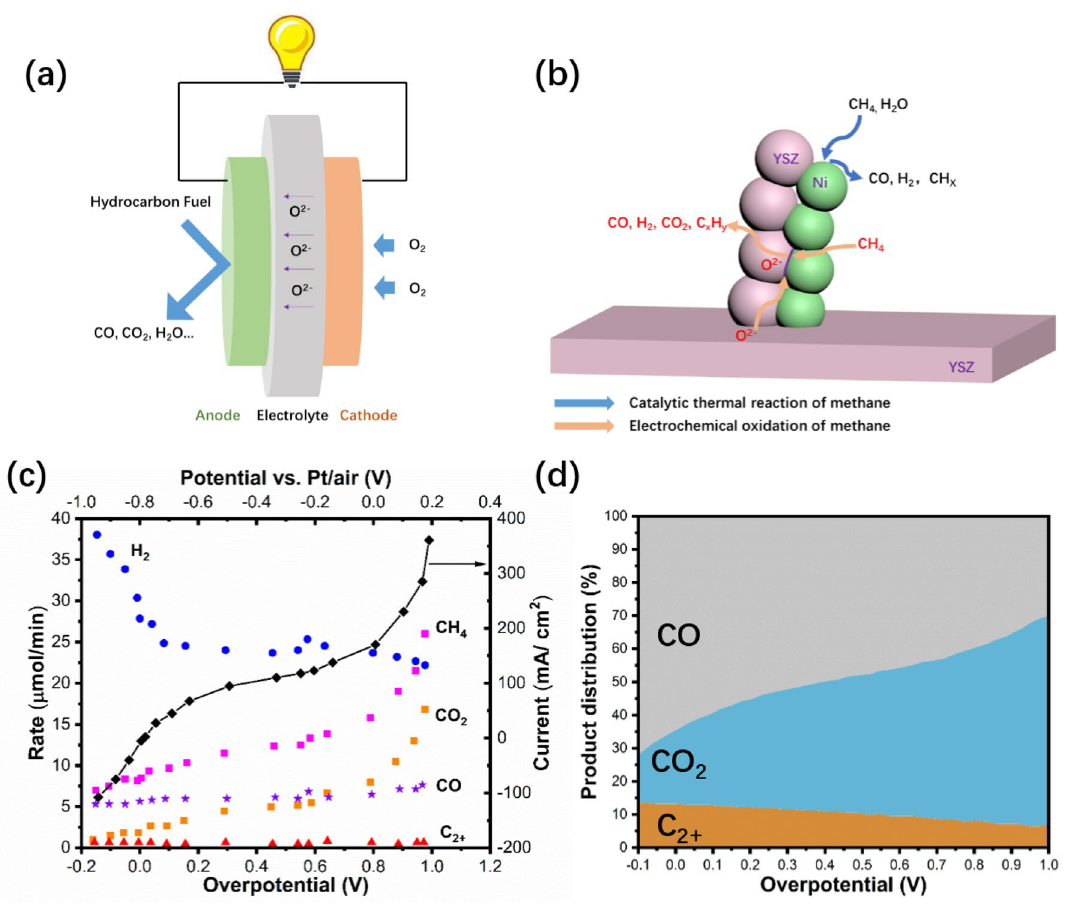
Fig. 2 a Working principle of hydrocarbon fueled SOFCs. b Sche- matic illustration of thermal and electrochemical oxidation of meth- ane. c Current-overpotential curve of the Ce 0.6 Gd 0.4 O 1.8 electrode vs. air and the production rates of H 2 , CO, CO 2 , C 2+ hydrocarbons as